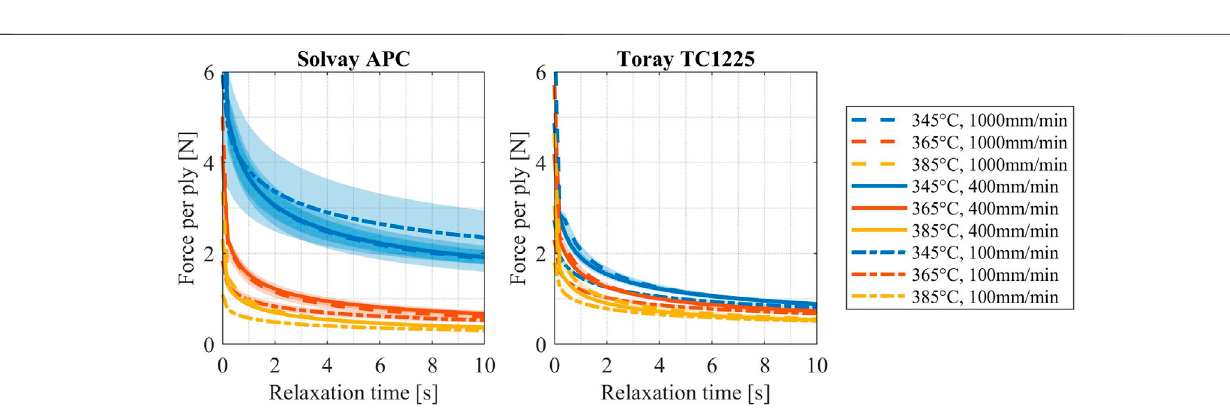
Frontiers in Materials |